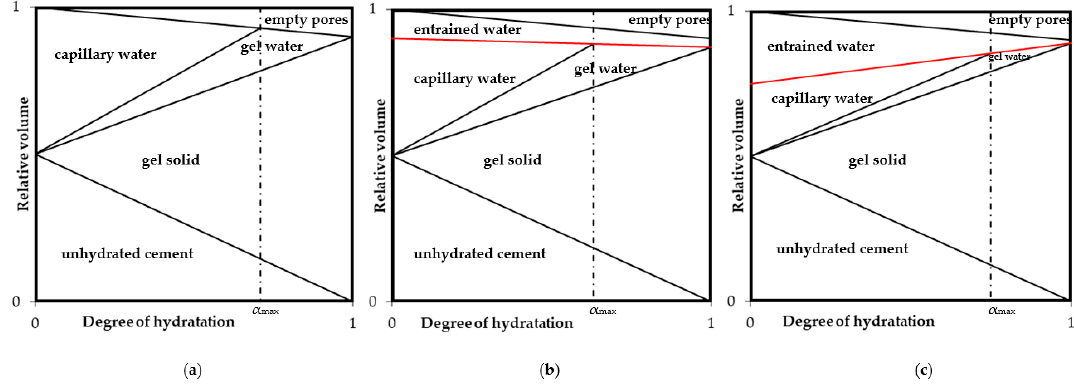
Figure 4. Powers model in three variants. ( a ) Sealed system, not modified with superabsorbent polymers; hydration takes place until the capillary water is exhausted [47]; ( b ) Sealed system, modified by superabsorbent polymers based on the dosing method assuming the addition of non-activated SAP to other dry components of the mix; ( c ) Sealed system, modified with superabsorbent polymers based on the dosing method involving the addition of a mixture of previously activated SAP and remaining mixing water to the rest of components of the concrete mix. A detailed description of charts in the text.